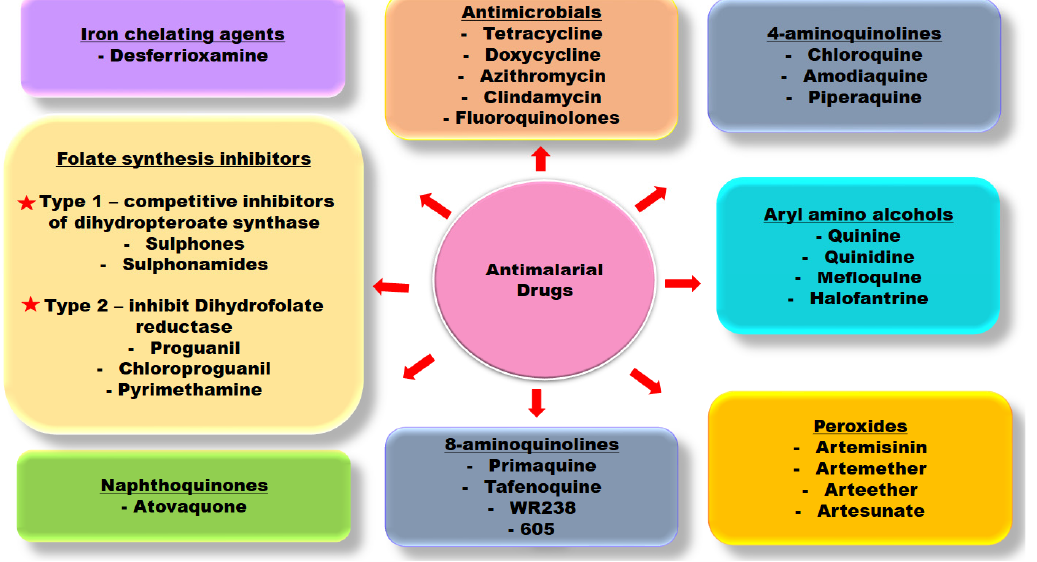
Figure 1. Class of antimalarial drugs in clinical usage. Table 1. Selected antimalarial drugs and their mode of action upon administration. Antimalarial Classification Mode of Action Artemisinin and derivatives;